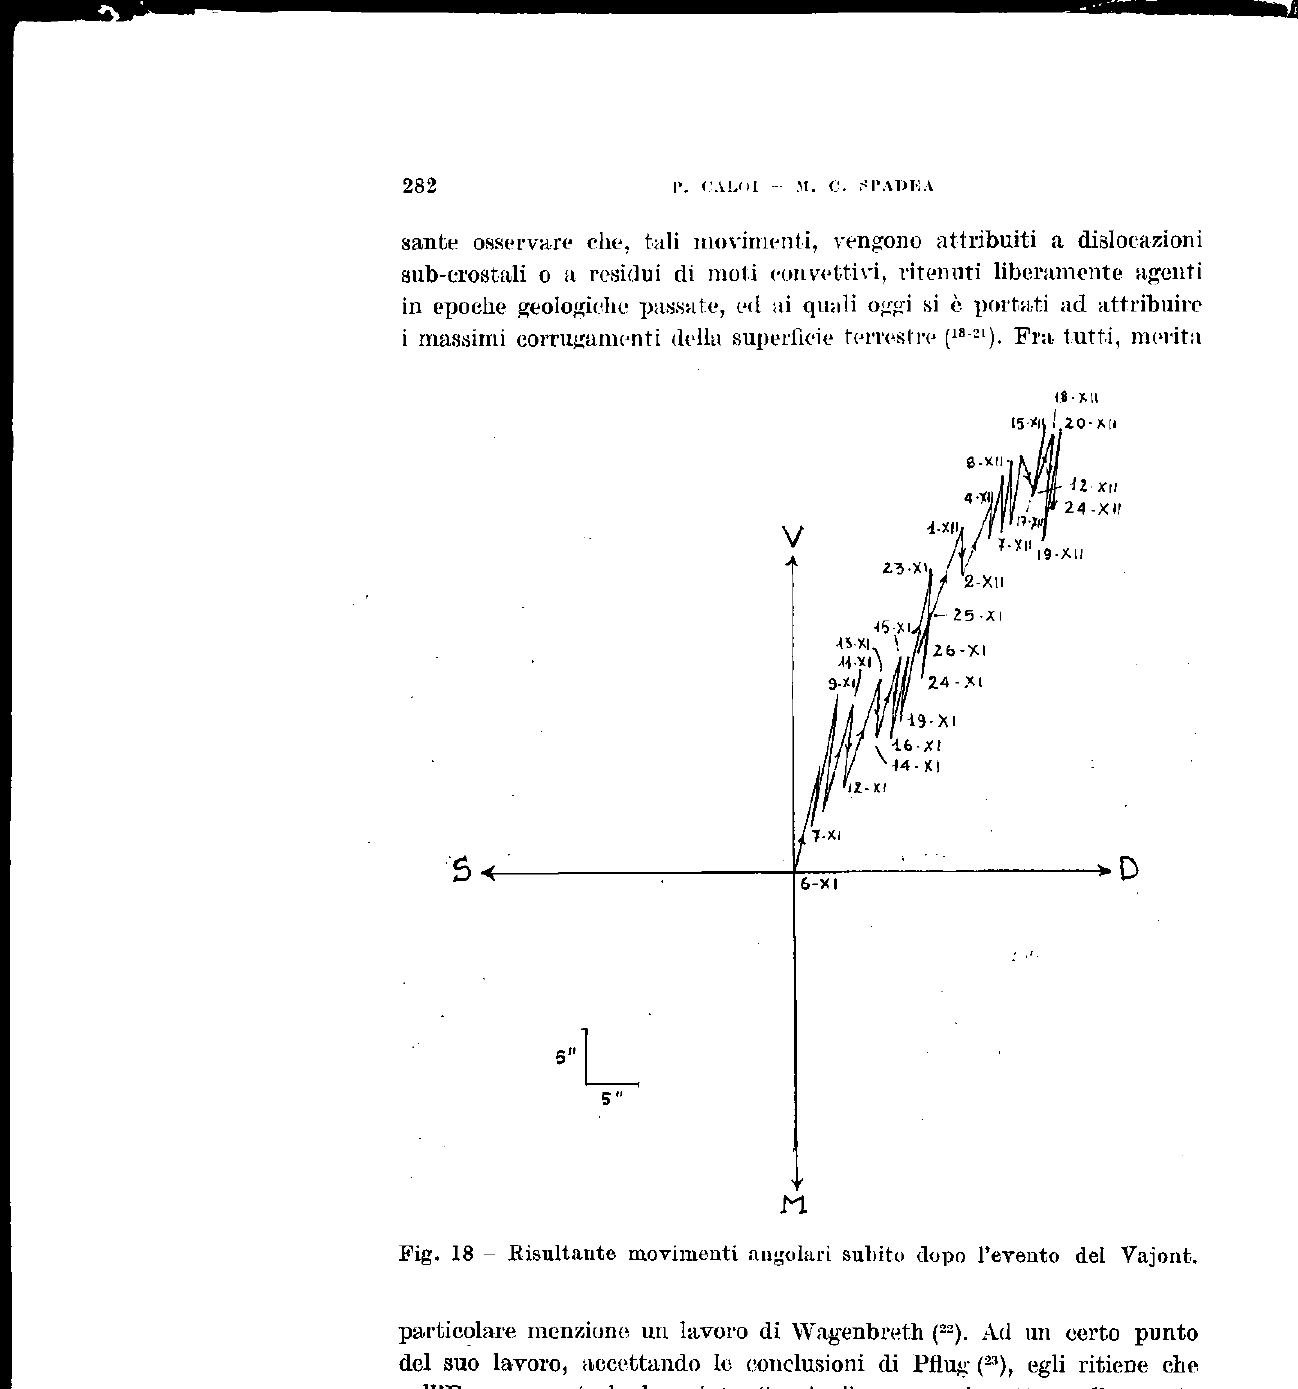
particolare menzione un lavoro di Wagenbreth ( 22 ). Ad un certo punto del suo lavoro, accettando le conclusioni di Pflug ( 23 ), egli ritiene che nell'Europa centrale le spinte (tensioni), ancora in atto, nella crosta terrestre siano come da Fig.